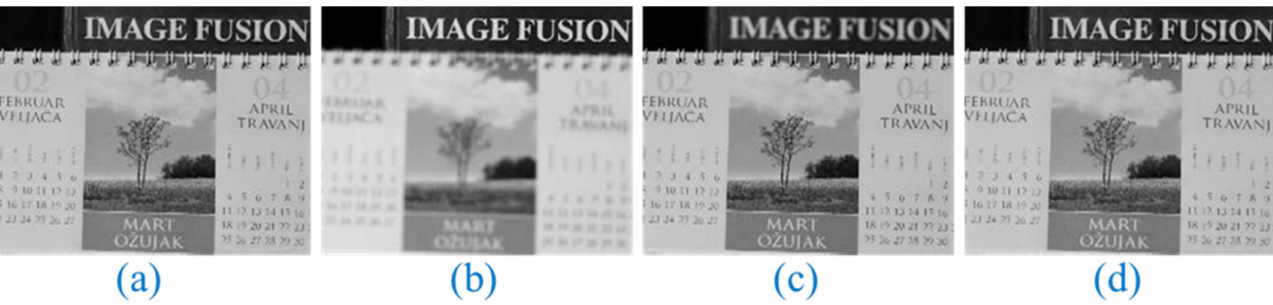
Figure 7. Multi-focus image of a craft from various perspectives. Original Image: ( a ), Multi-focus Input Images: ( b , c ), and Proposed Fusion: ( d ).